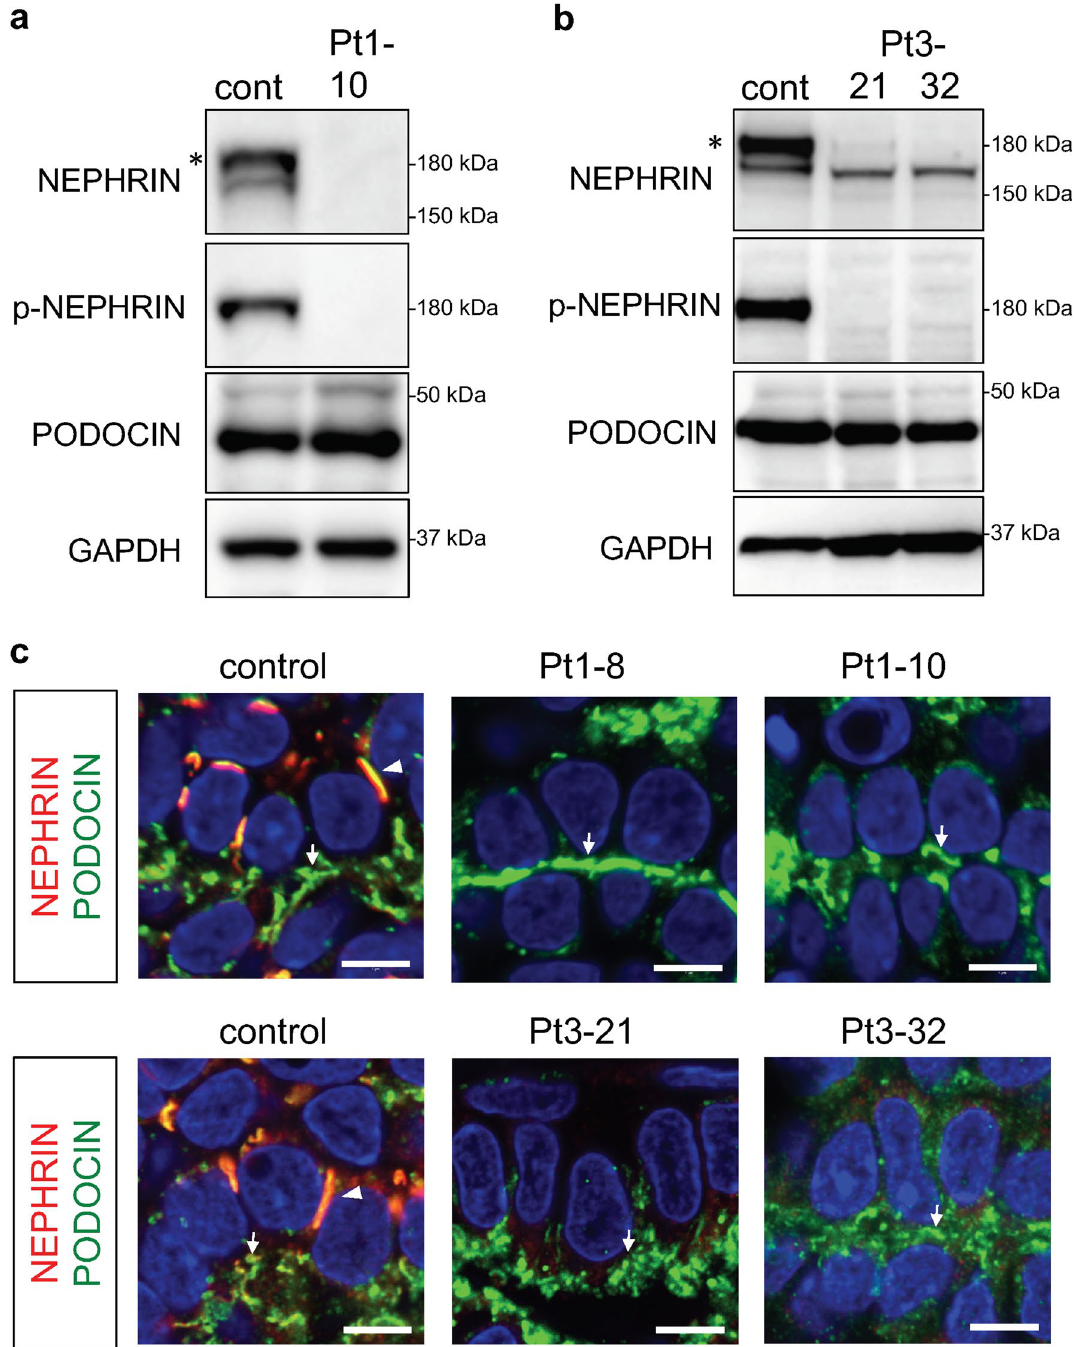
Figure 6. Localizations of NEPHRIN and PODOCIN are impaired in patient-derived podocytes. ( a ) Western blot analyses of NEPHRIN and PODOCIN in kidney organoids derived from Patient 1. NEPHRIN is absent in the patient-derived organoids. ( b ) Western blot analyses of NEPHRIN and PODOCIN in kidney organoids derived from Patient 3. The upper band of NEPHRIN (*) is missing in the patient-derived organoids. NEPHRIN phosphorylation is also undetectable. p-NEPHRIN: phosphorylated NEPHRIN. The results from the different blots were combined, as depicted by the solid boxes. ( c ) Section immunostaining of kidney organoids, showing the impaired localizations of NEPHRIN and PODOCIN in the patient-derived podocytes (upper row: Patient 1; lower row: Patient 3). PODOCIN is undetectable in the lateral domains of the podocytes derived from both patients. Arrowheads: lateral SD precursors; arrows: basal PODOCIN + domains. Scale bars: 5